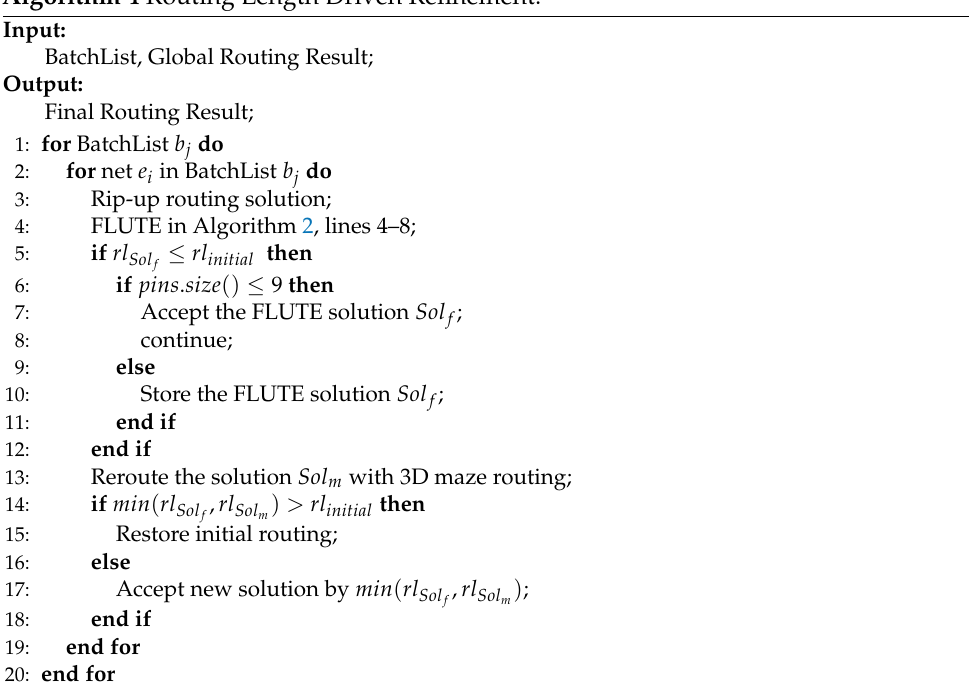
Algorithm 4 Routing Length Driven